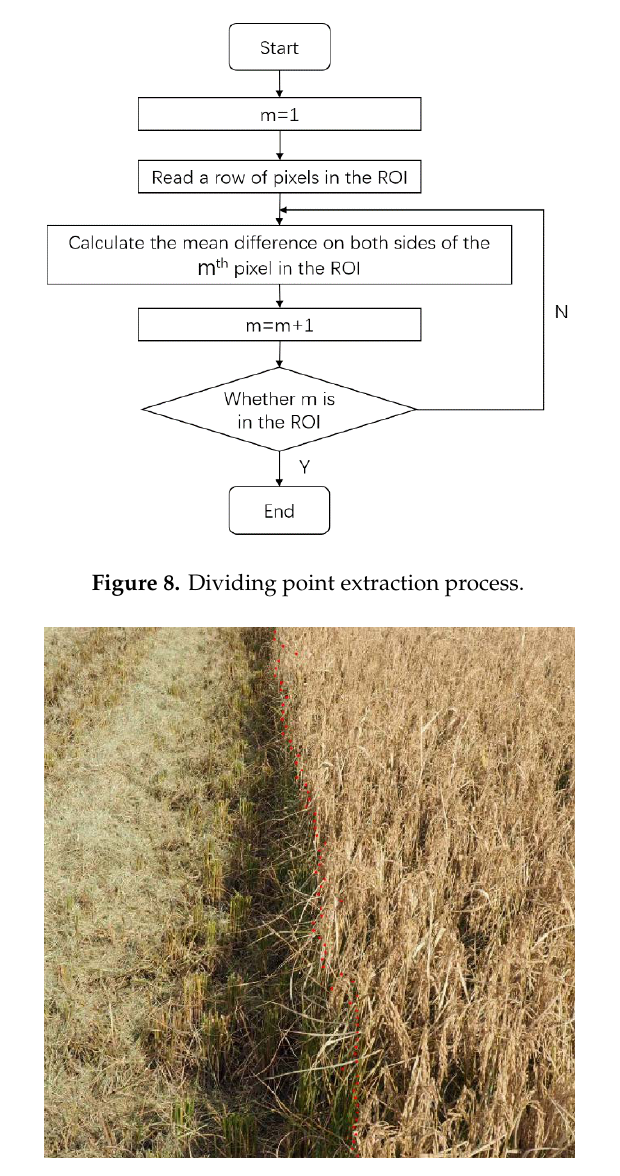
Figure 9. Dividing point extraction effect.